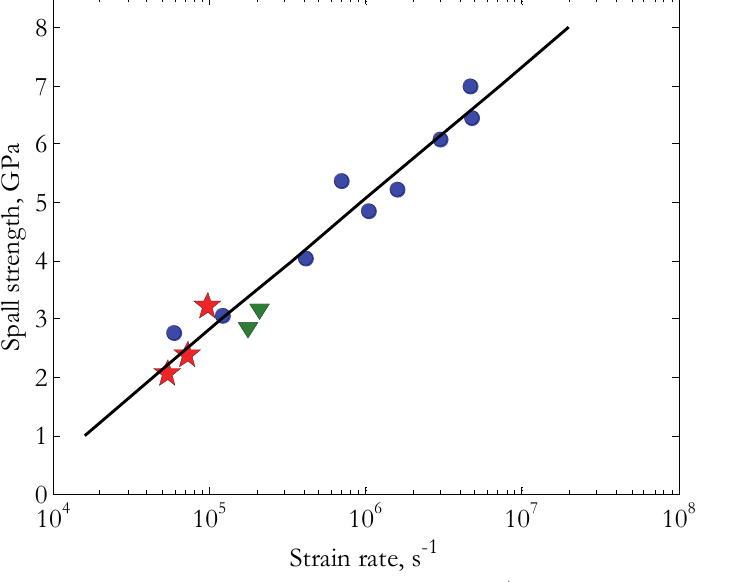
Figure 5: Dependence of spall strength versus strain rate: ● − experiment [25], − model calculation, ▼ − experiment